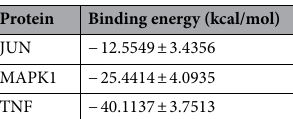
Table 2. The calculated binding energy of quercetin against JUN, MAPK1 and TNF.